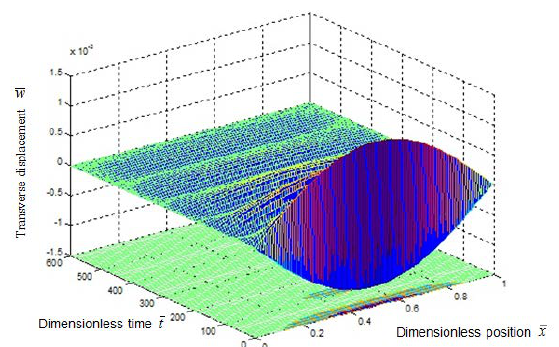
Figure 13. Dynamic response of the transverse displacement profile for the case R i = 0 . 41 m,γ = 0 . 02 ,n = 1 ,δ 0 . 3721 , ¯ U = 0 . 01 , Θ = 250 ◦ C,χ 1 = − 0 . 2